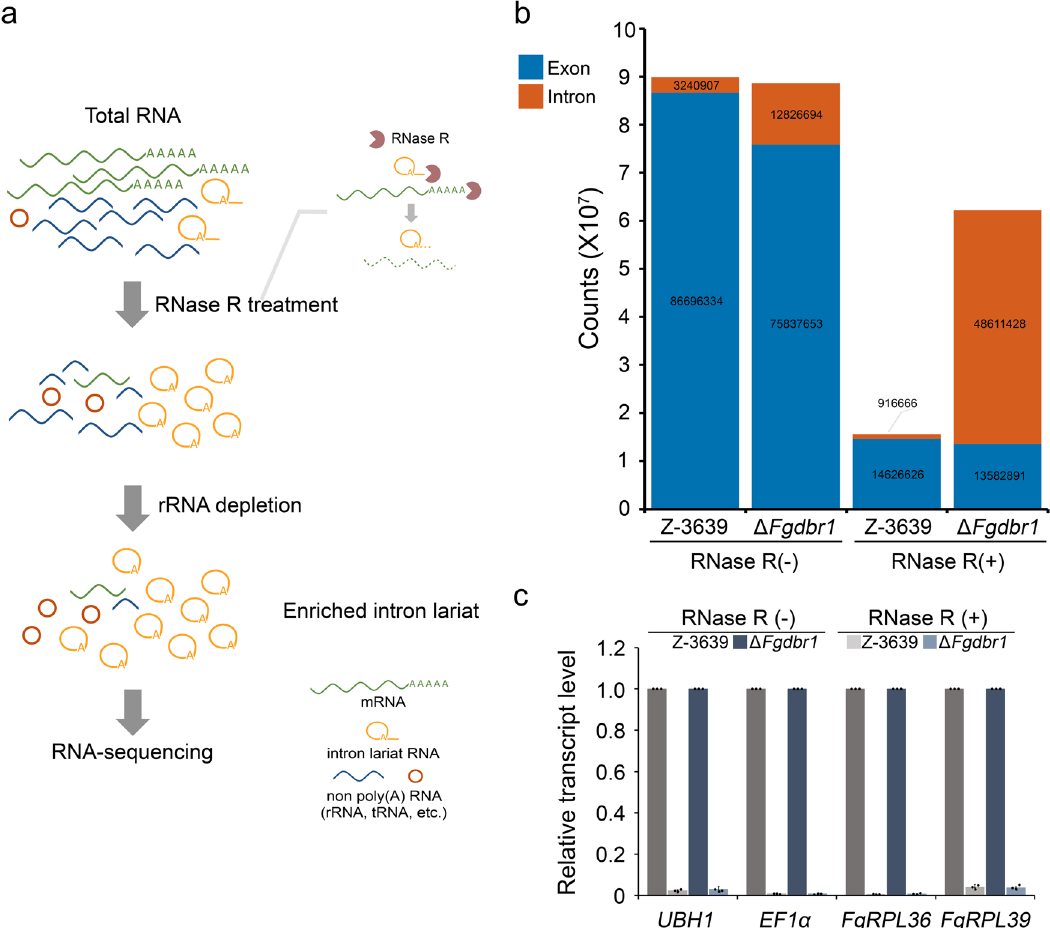
Fig. 4 Transcriptome analysis of RNase R- treated or untreated samples in F . graminearum strains. a Work fl ow of intron lariat enrichment for RNA sequencing (RNA-seq). Total RNA was extracted from each strain grown for 24 h in liquid CM and digested with RNase R for linear RNA degradation. The remaining RNAs were further subjected to rRNA depletion and subsequently used for RNA-seq library construction. b Distribution of mapped read counts originating from exonic and intronic regions. c Veri fi cation of the elimination of linear RNA by RNase R. Relative transcript levels of the wild- type and Δ Fgdbr1 samples with or without RNase R treatment were determined by qRT-PCR analysis. Error bars represent standard deviations of three biological